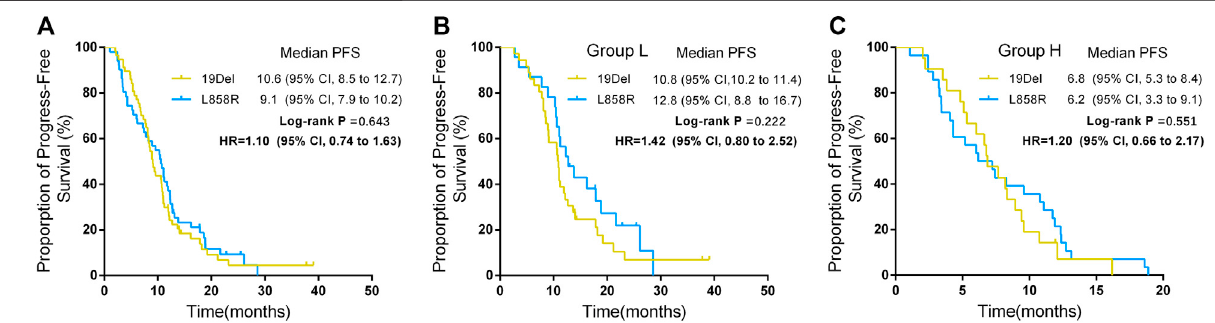
Frontiers in Molecular Biosciences |